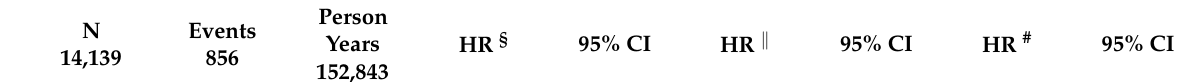
Table 2. Hazard Ratios (HRs) of Ischemic Stroke, by Categories of Average Body Mass Index to the end of Follow-up with Repeated Updated Exposure and by Categories of Average Body Mass Index Until the HUNT3 Measurement (BMI 07